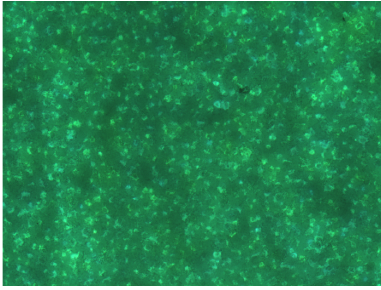
Figure 10 . Fluorescence image of a cured (500 – C) enamel/phosphor composite, taken through the substrate glass under UV illumination (366nm). Image width: 2